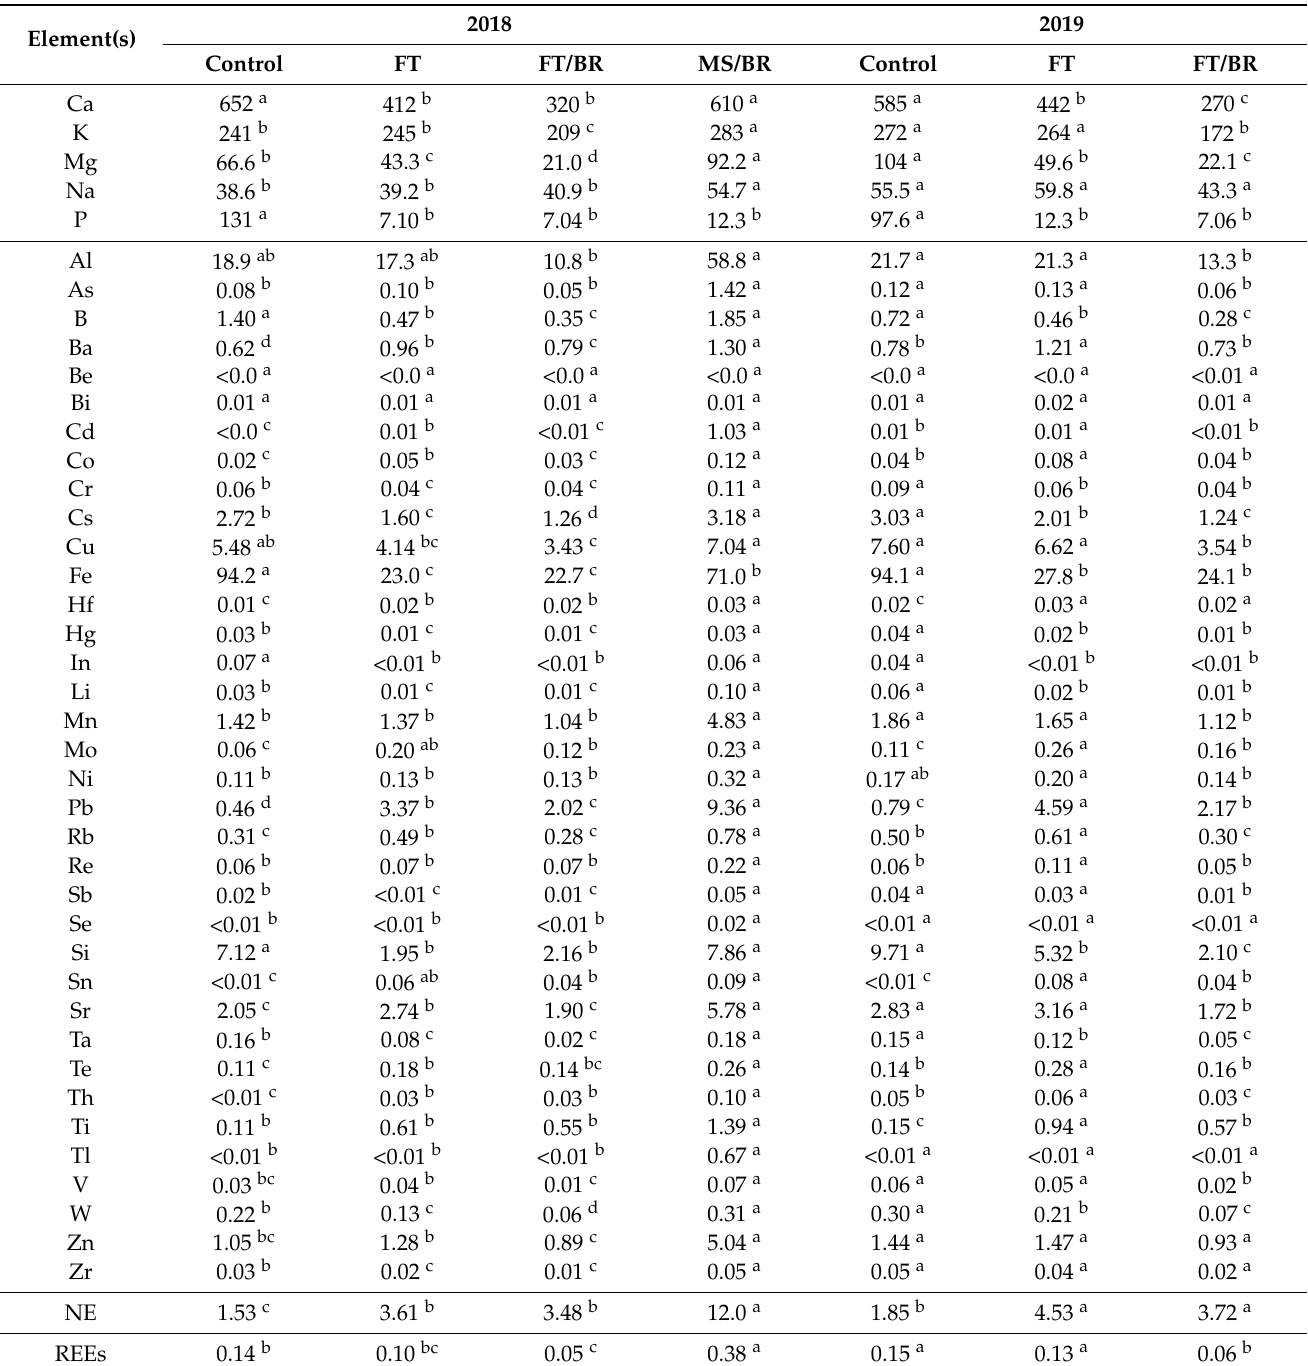
Table 3. Content of major and trace elements (mg per plant DW) in Paulownia plants growing in particular experimental systems ( n =